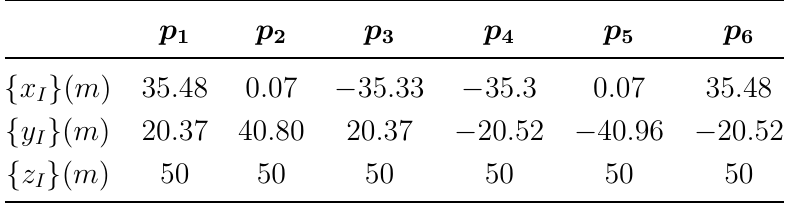
Table 1. Optimal sensor positions for constant covariance.